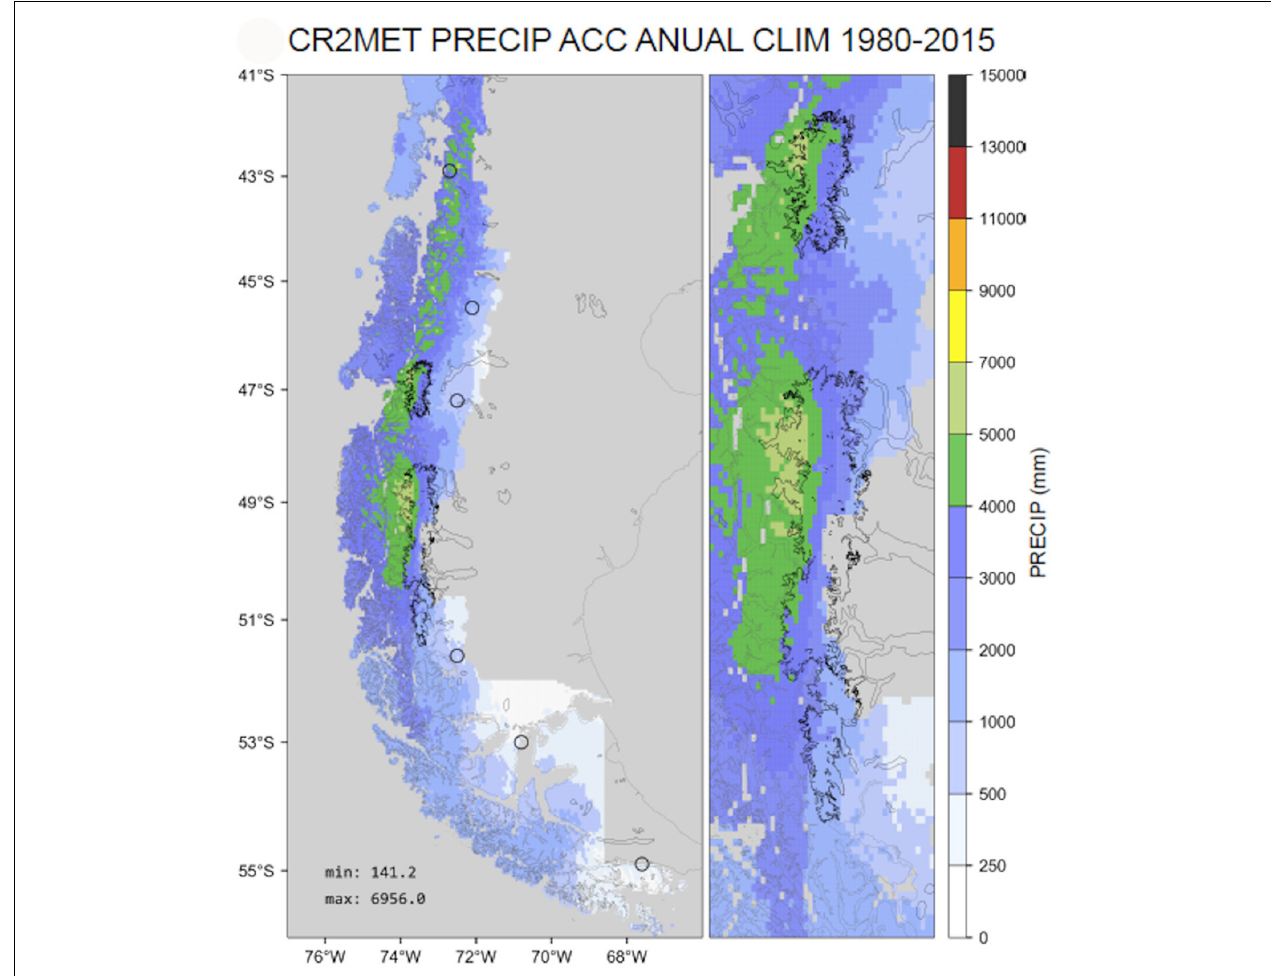
FIGURE 4 | Mean annual precipitation of Chilean Patagonia 1980–2015, R. Garreaud (personal communication), see Alvarez-Garreton et al.